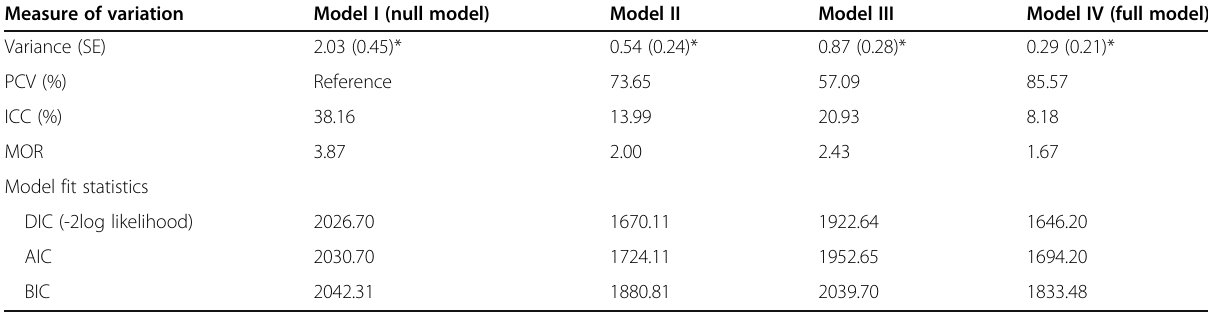
Table 4 Measure of variation on individual and community level risk factors of neonatal in rural Ethiopia, EDHS 2016 dataset Measure of